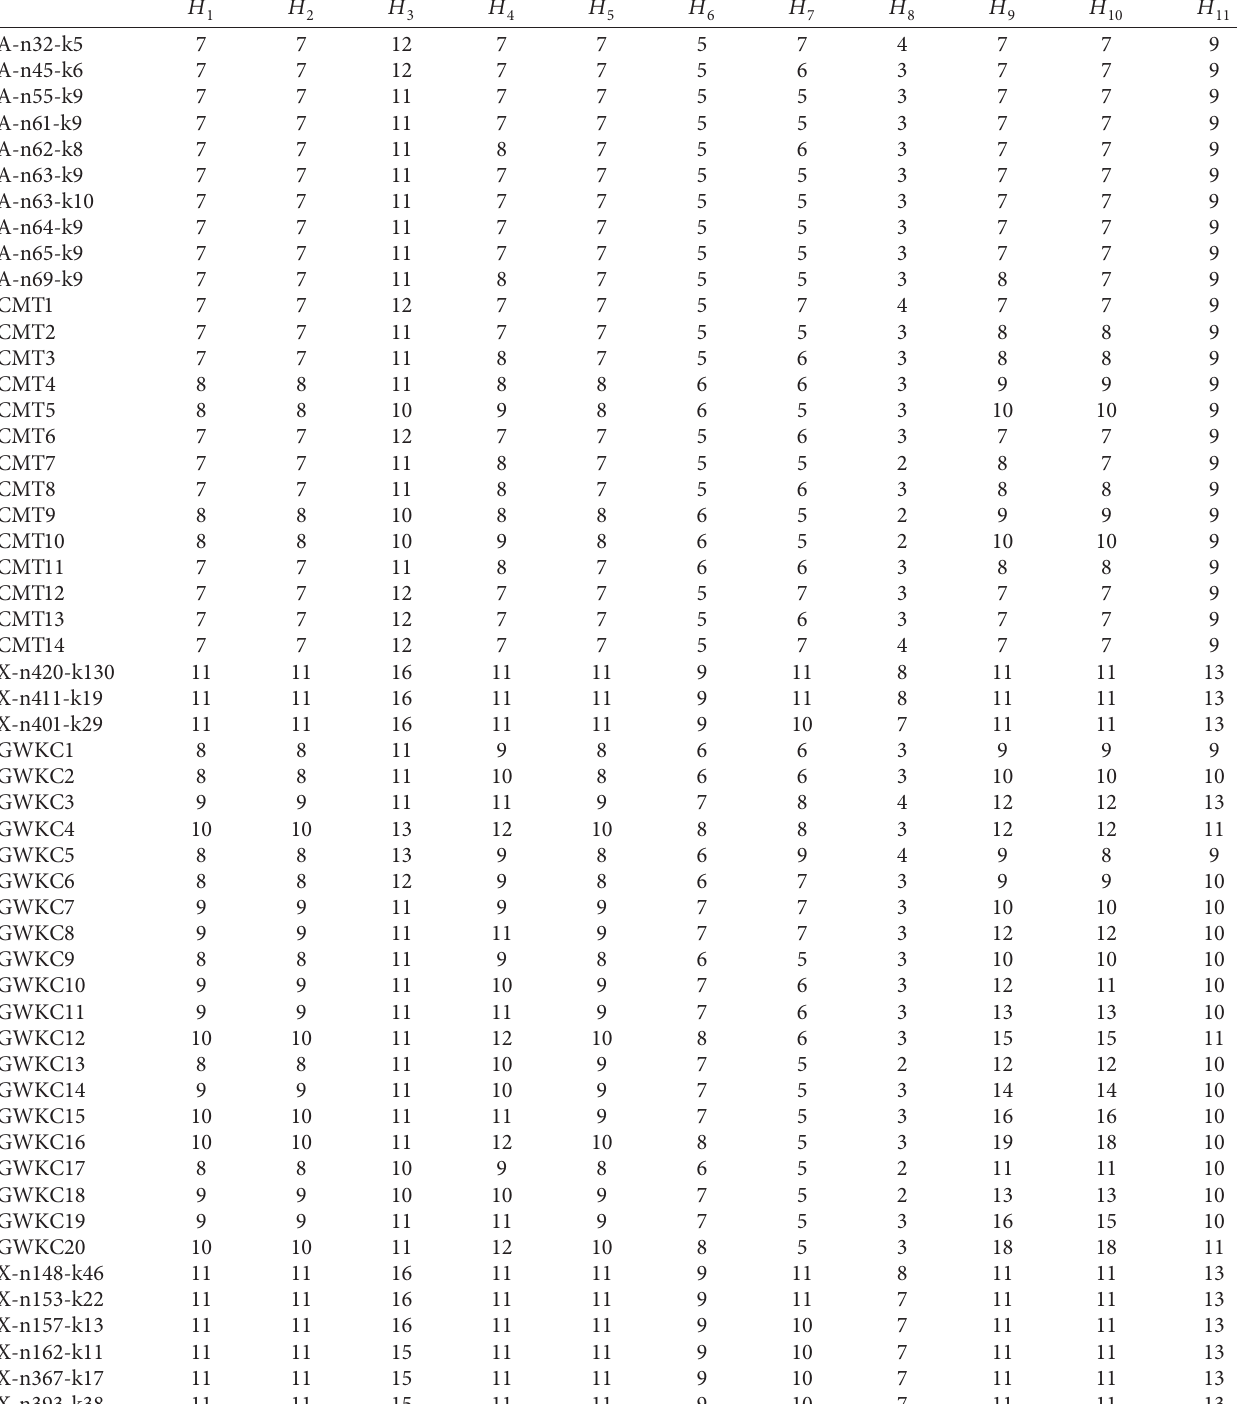
Table 10: Time for one run of each heuristic in seconds for CVRP-capacitated instances. H 1